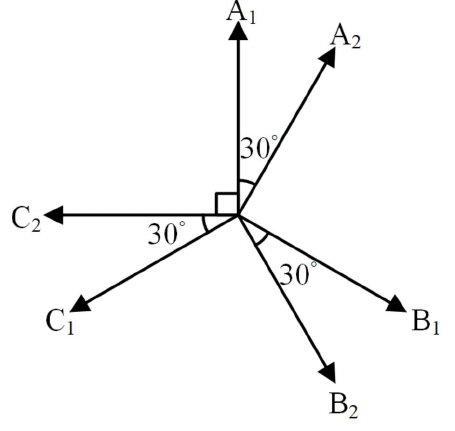
Figure 4. Spatial layout of dual three-phase stator winding.